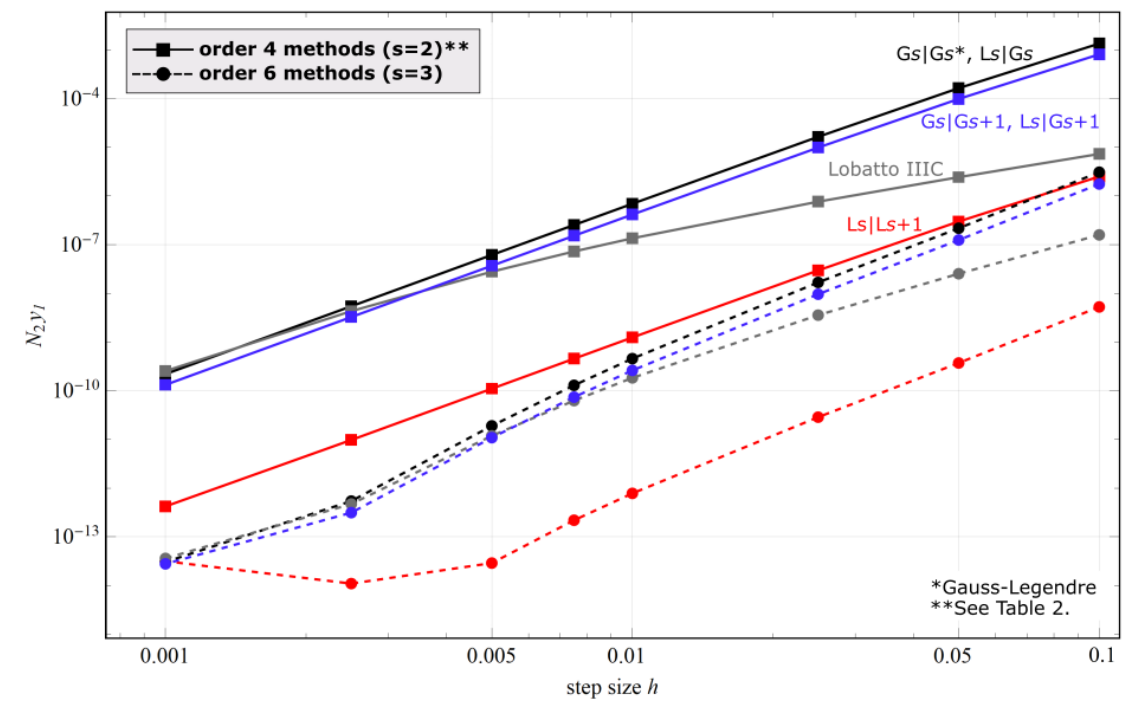
Figure 2. The error of different methods (as the L 2 norm) vs. the step size in Example 2 (log–log scale). The method accuracy is provided in Table 2.